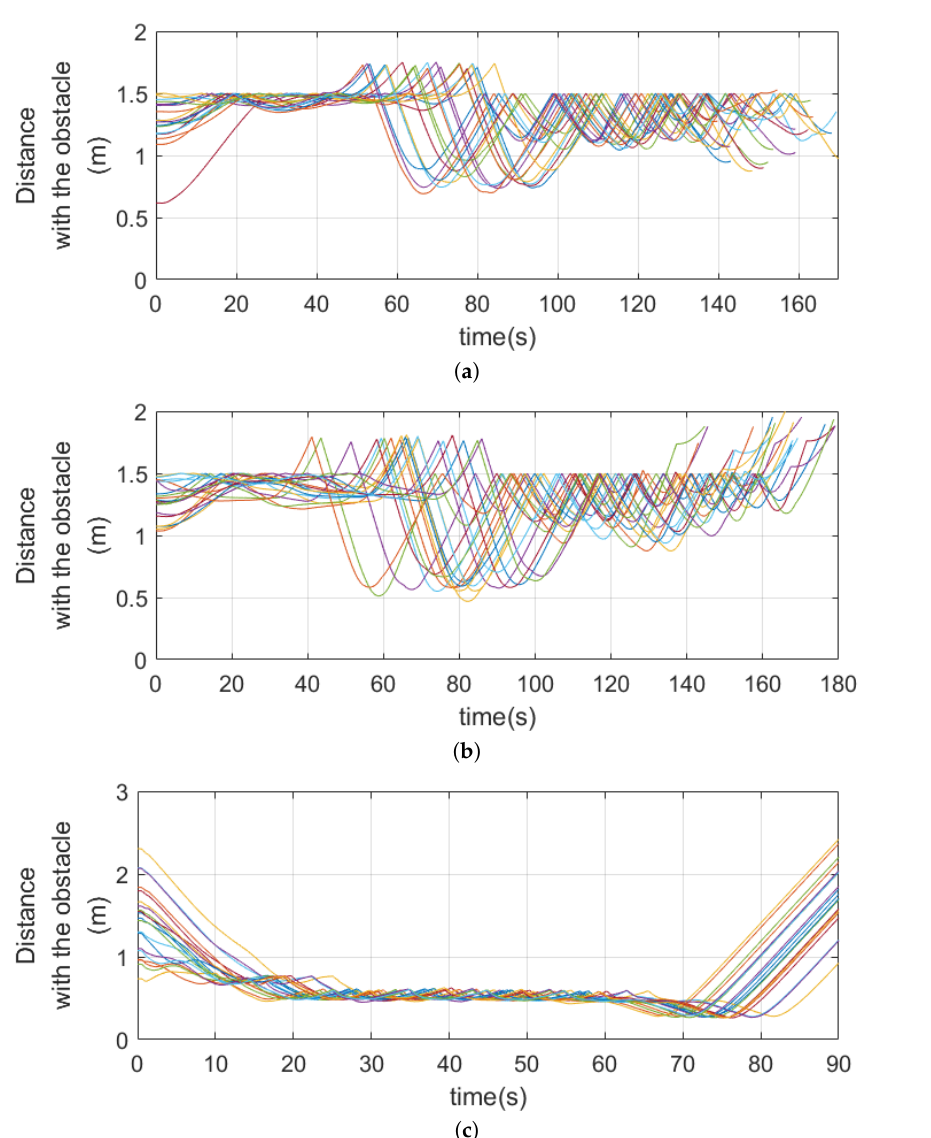
Figure 9. Distance to obstacles in: ( a ) the L-shape corner; ( b ) the T-shape junction; and ( c ) the ramp shape. The hybrid obstacle avoidance strategy was also verified in the complex environment surrounded by walls and containing horizontal columns, as described in Figure 10. Figure 11 shows simulation results such as the image from the camera, optical flows and its magnitude at each window, magnitude of the EOF and its time history, and trajectory of the MAV during the simulation. In the EOF time history, the red dashed line represents where the sigmoid weighting for the obstacle avoidance strategy changed rapidly (i.e., η ≥ η eta ,0 = 3). At 50 s, as shown in Figure 11a, the EOF was around 2 and the MAV avoided surrounding walls by using the horizontal balance strategy. At 241 s, as shown in Figure 11b, as the MAV approached the frontal wall, the EOF became large and the frontal obstacle avoidance strategy was dominant, which made the MAV turn sharply. At 558 s, as shown in Figure 11c, as the optical flow in the lower half plane in the vertical optical flow window was bigger than in the upper half plane, the